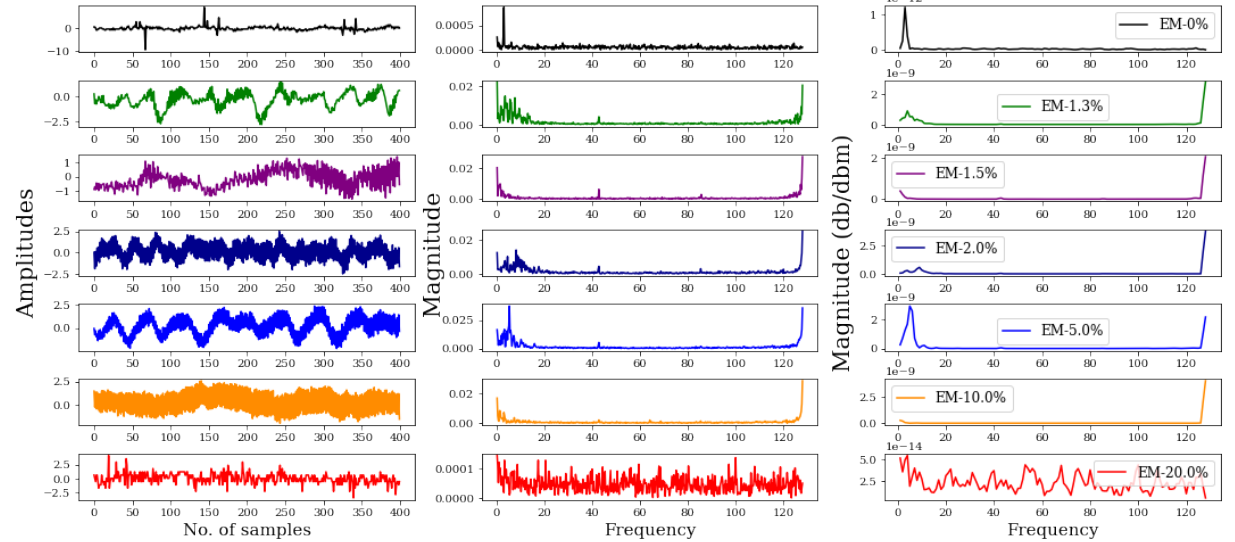
Figure A5. CR signals and their FFT and PSD outputs at 2000 RPM for the emulsion compositions.